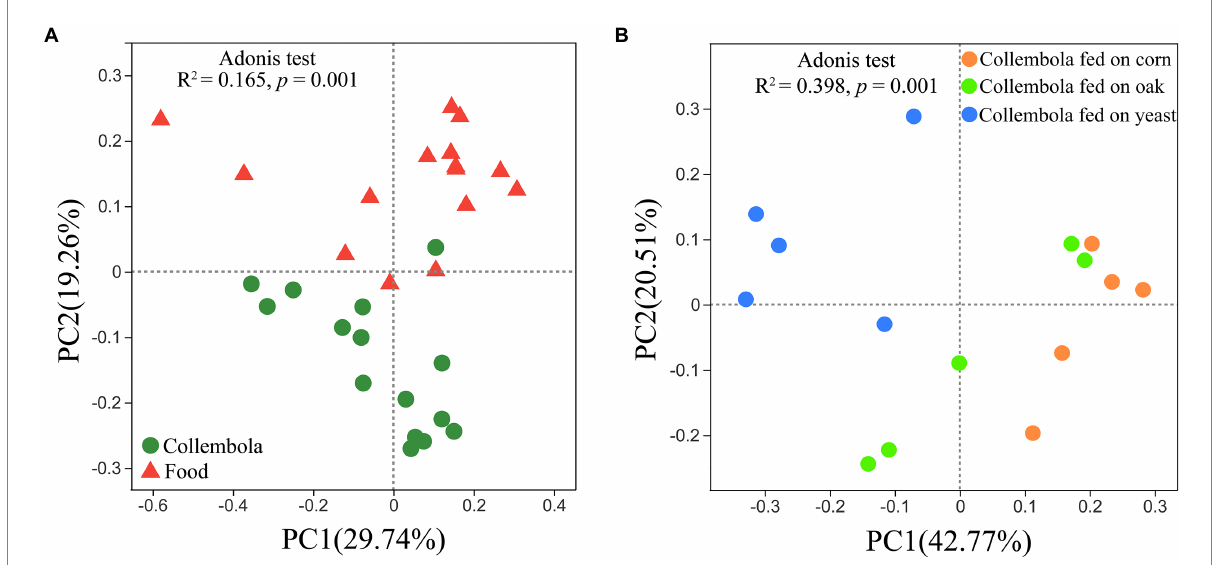
FIGURE 3 Bacterial community structure in cold-adapted Collembola and food types. Weighted-UniFrac principal coordinate analysis (PCoA) plots describe the differences in bacterial community structure between Collembola and food samples (A) , as well as the differences in bacterial community between Collembola fed with different food resources (B)